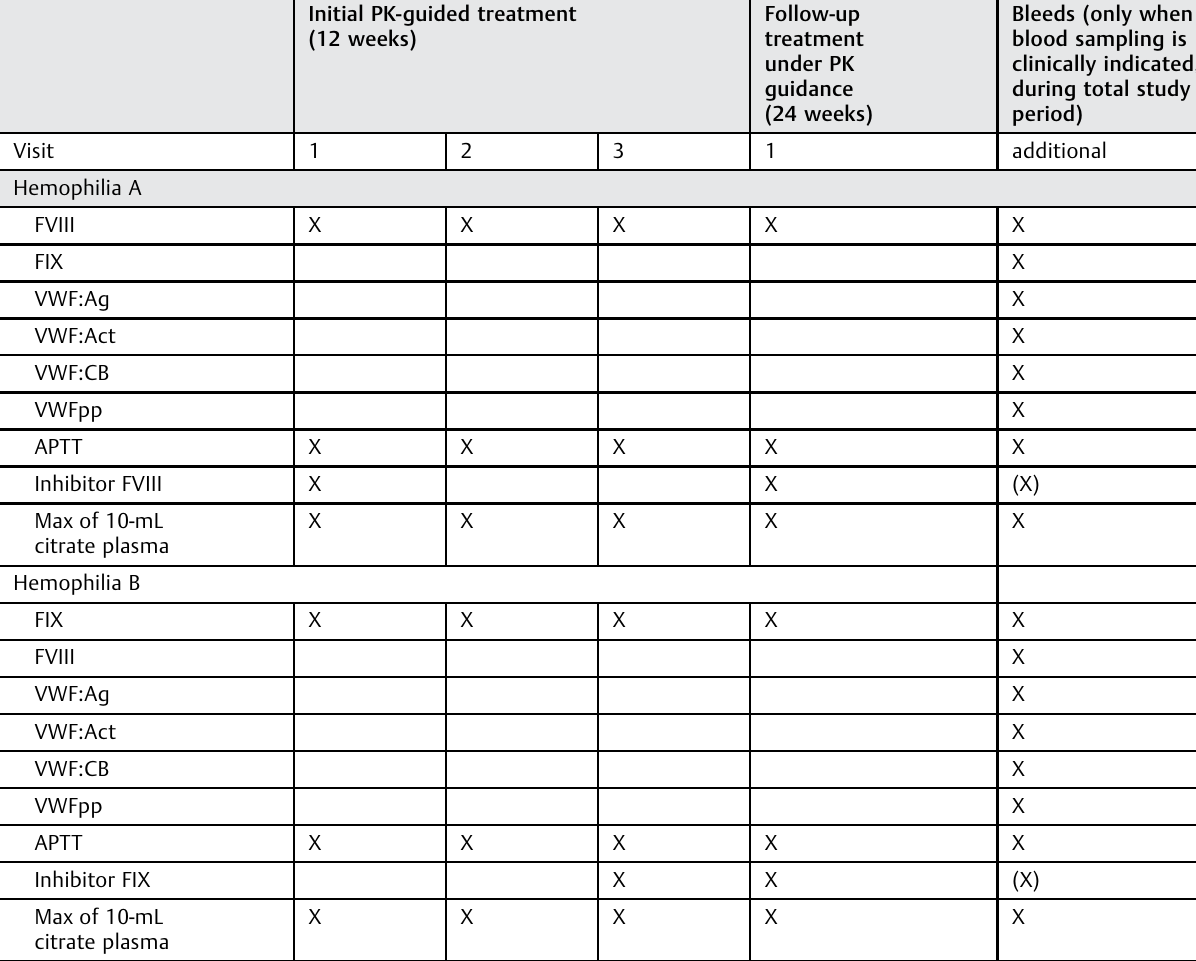
Table 3 Laboratory tests during initial PK-guided treatment and follow-up Initial PK-guided treatment (12